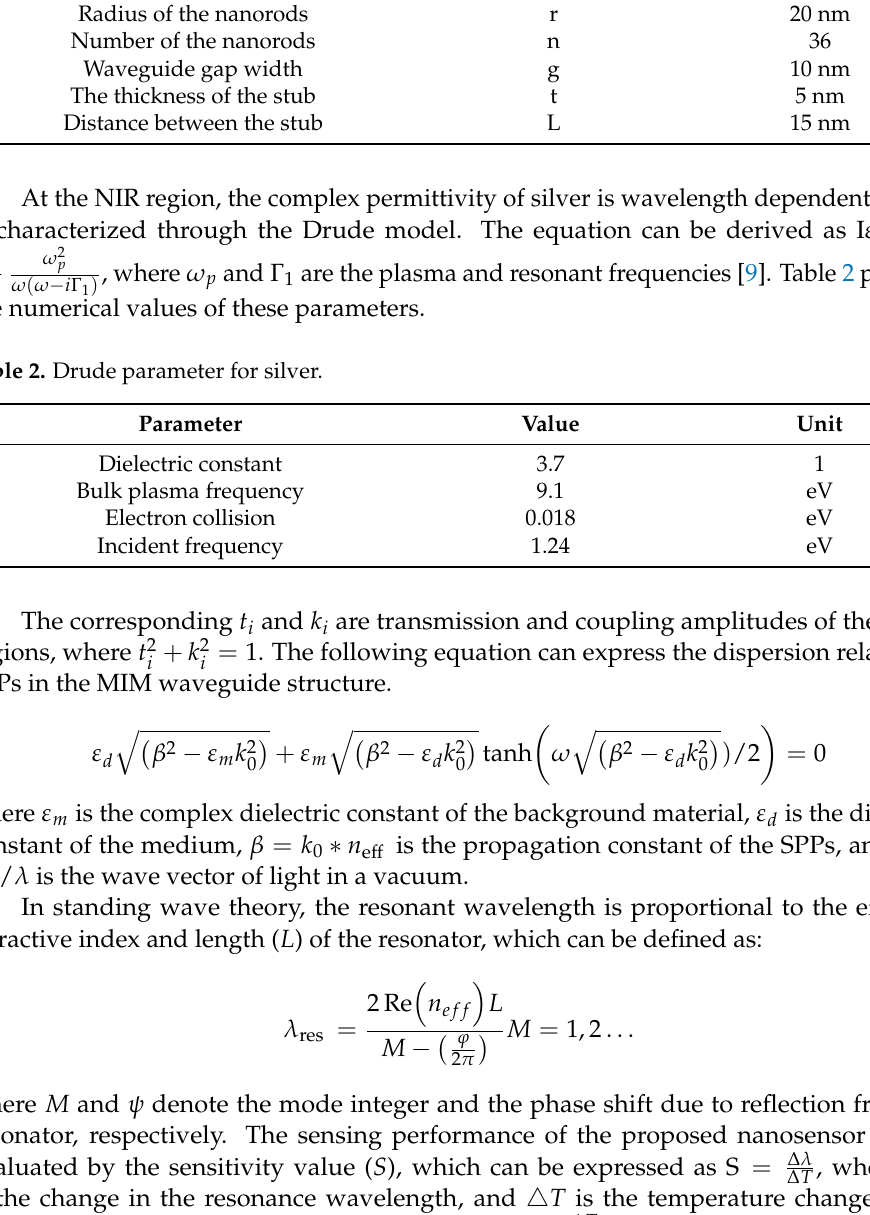
Table 1. Initial simulation parameters of the sensor. Parameter Symbol Value Waveguide width w 50 nm Inner radius R1 300 nm Outer radius R2 350 nm Radius of the nanorods r 20 nm Number of the nanorods n 36 Waveguide gap width g 10 nm The thickness of the stub t 5 nm Distance between the stub L